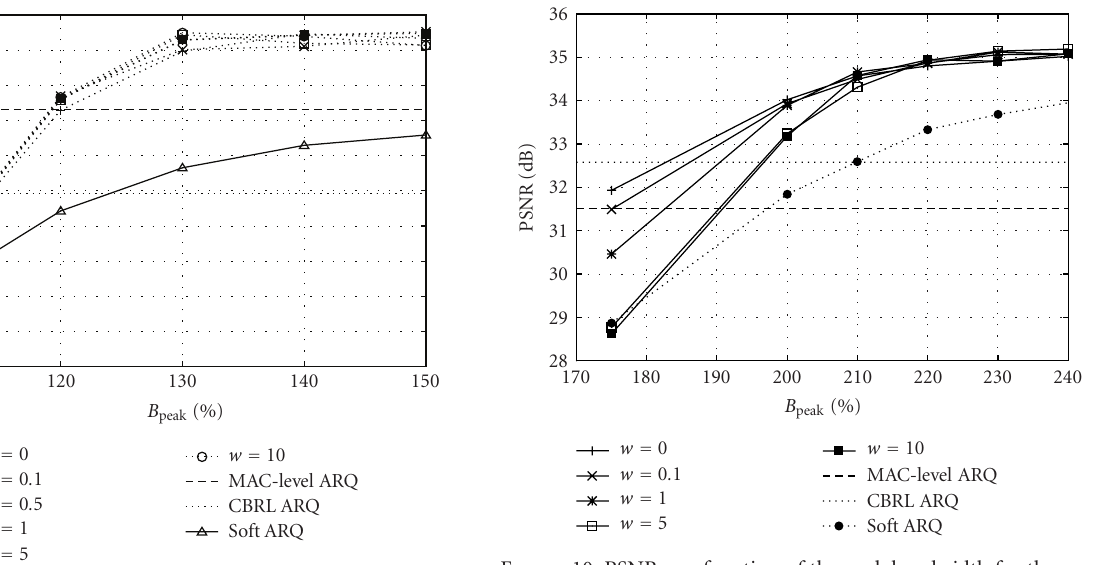
Figure 9: Used bandwidth as a function of the peak bandwidth for the proposed ARQ scheme, compared to the Soft ARQ technique and to the value corresponding to the best PSNR performance of the MAC-level ARQ scheme ( bus sequence).